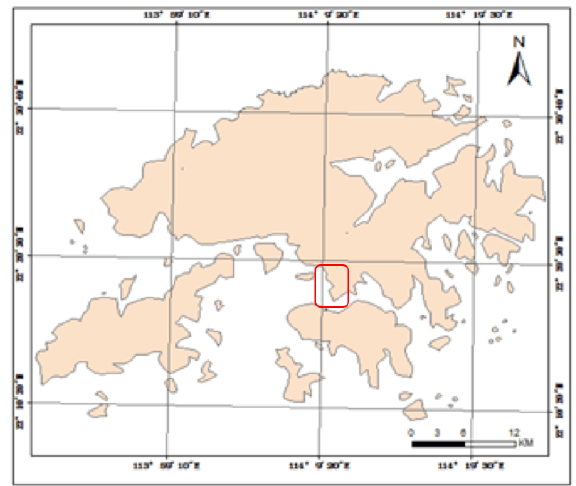
Fig. 3. The administrative scope of Hong Kong and the research